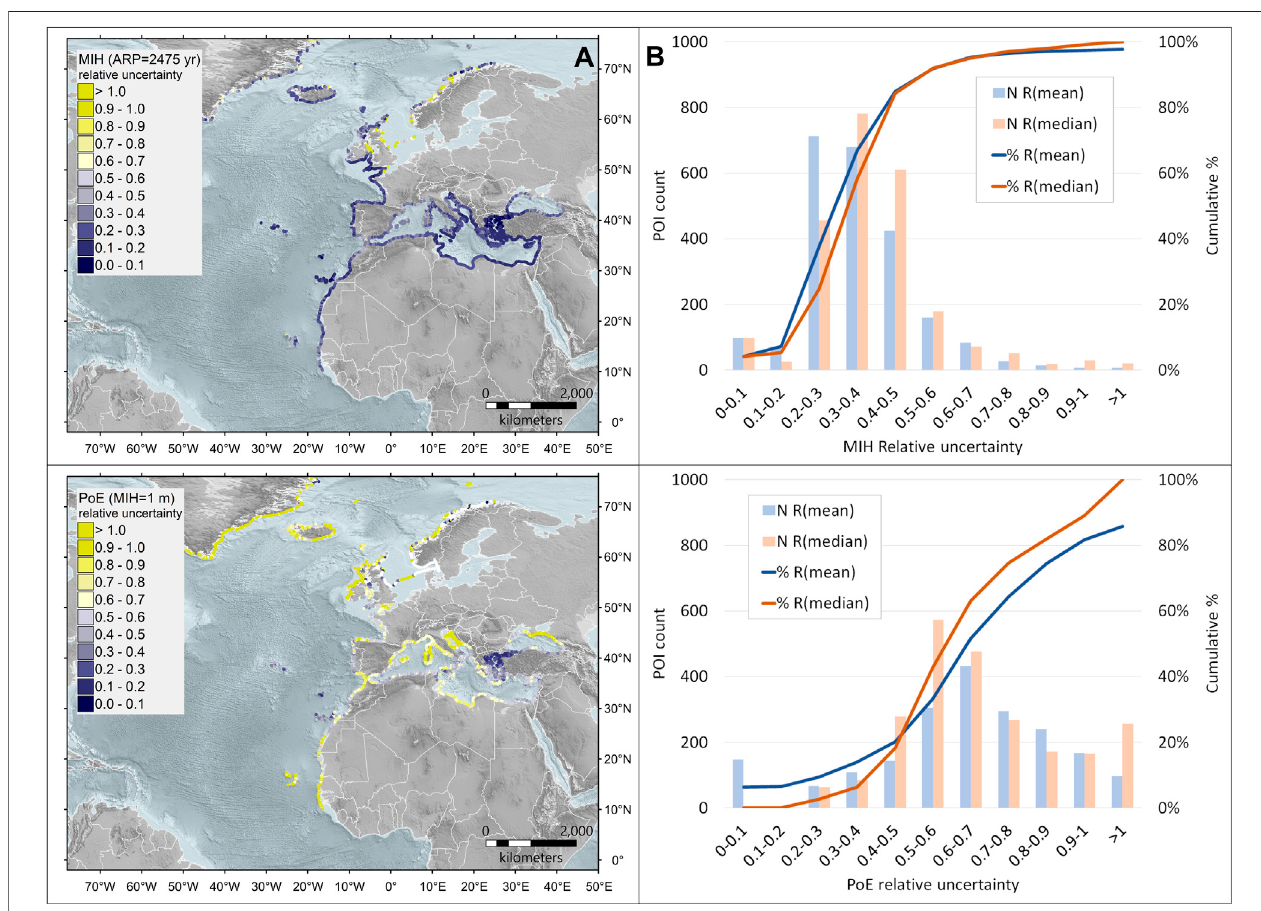
FIGURE 13 | (A) Geographic distributions of the maximum inundation height (MIH) relative uncertainty, de fi ned as the ratio R (cid:3) ( MIH p84 -MIH mean ) /MIH mean , for the 2% probability of exceedance in 50 years, equivalent to an average return period of 2,475 years (upper) , and of the probability of exceedance relative uncertainty, de fi ned as the ratio R (cid:3) ( PoE p84 -PoE mean ) /PoE mean , for the maximum inundation height of 1 m (lower) . Topo-bathymetry is from the ETOPO1 Global Relief Model (NOAA, 2009; Amante and Eakins, 2009). (B) Incremental and cumulative distribution of the relative uncertainty as de fi ned in panel (A) for MIH (upper) and PoE (lower) . For comparison, both diagrams also show the relative uncertainty with respect to the median.